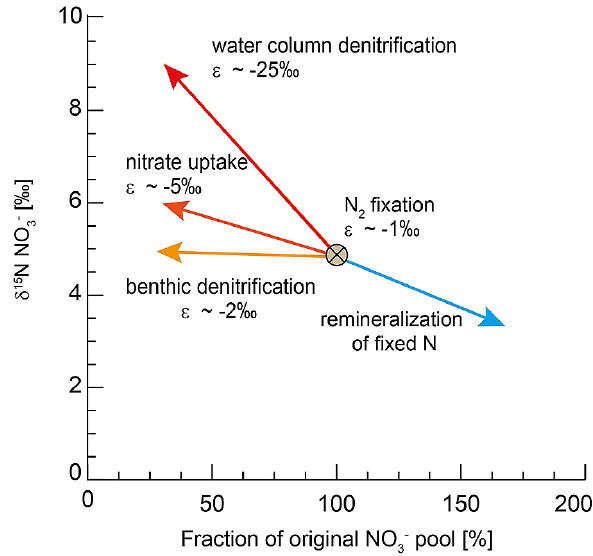
Fig. 1. Isotopic changes during nitrate turnover in the open ocean. After Gruber